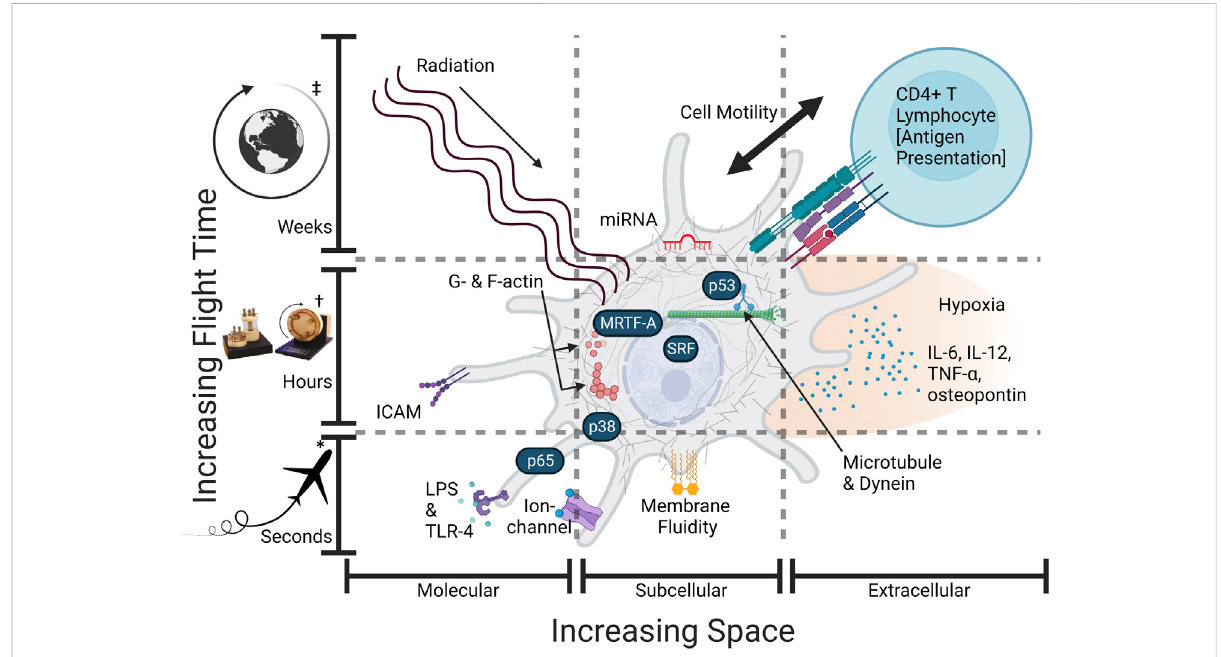
FIGURE 1 Some M ϕ space fl ight effects require more time or space. An overview of the altered space fl ight exposome (gravity, cytoskeleton, intracellular transport, hypoxia, radiation, intercellular signaling) and hypothetically relevant sensors and effector proteins: (LPS — lipopolysaccharide, TLR-4 — t oll-like receptor 4, G-actin — globular actin, F-actin — fi lamentous actin, microtubules, dynein, p53 — tumor protein P53, p38 — mitogen-activated protein kinase p38, MRTF — myocardin-related transcription factor-A or megakaryoblastic leukemia 1 ( MKL1 ), SRF — serum response factor, NF- κ B/p65 — nuclear factor kappa-light-chain-enhancer of activated B cells (p65 or RelA), IL-6 — interleukin 6, IL-12, TNF- α — tumor necrosis factor- alpha, osteopontin, ICAM-1 — intercellular adhesion molecule-1, miRNA — (microRNA such as miR-21 — microRNA-21-5p). Spatial variation occurs acrossmolecular,cellular,andphysiologicalscales(increasingspace).Timevariationoccursfromsecondsinmicrogravitytomonthsfromlong-term radiation (increasing time). Effects are not mutually exclusive and may interact at multiple scales, i.e., microgravity fi rst acts alone and later acts in conjunction with radiation. Created with BioRender.com. *Parabolic Flight, † Simulated microgravity culture vessel (not fl ight), ‡ Long-term orbital space fl